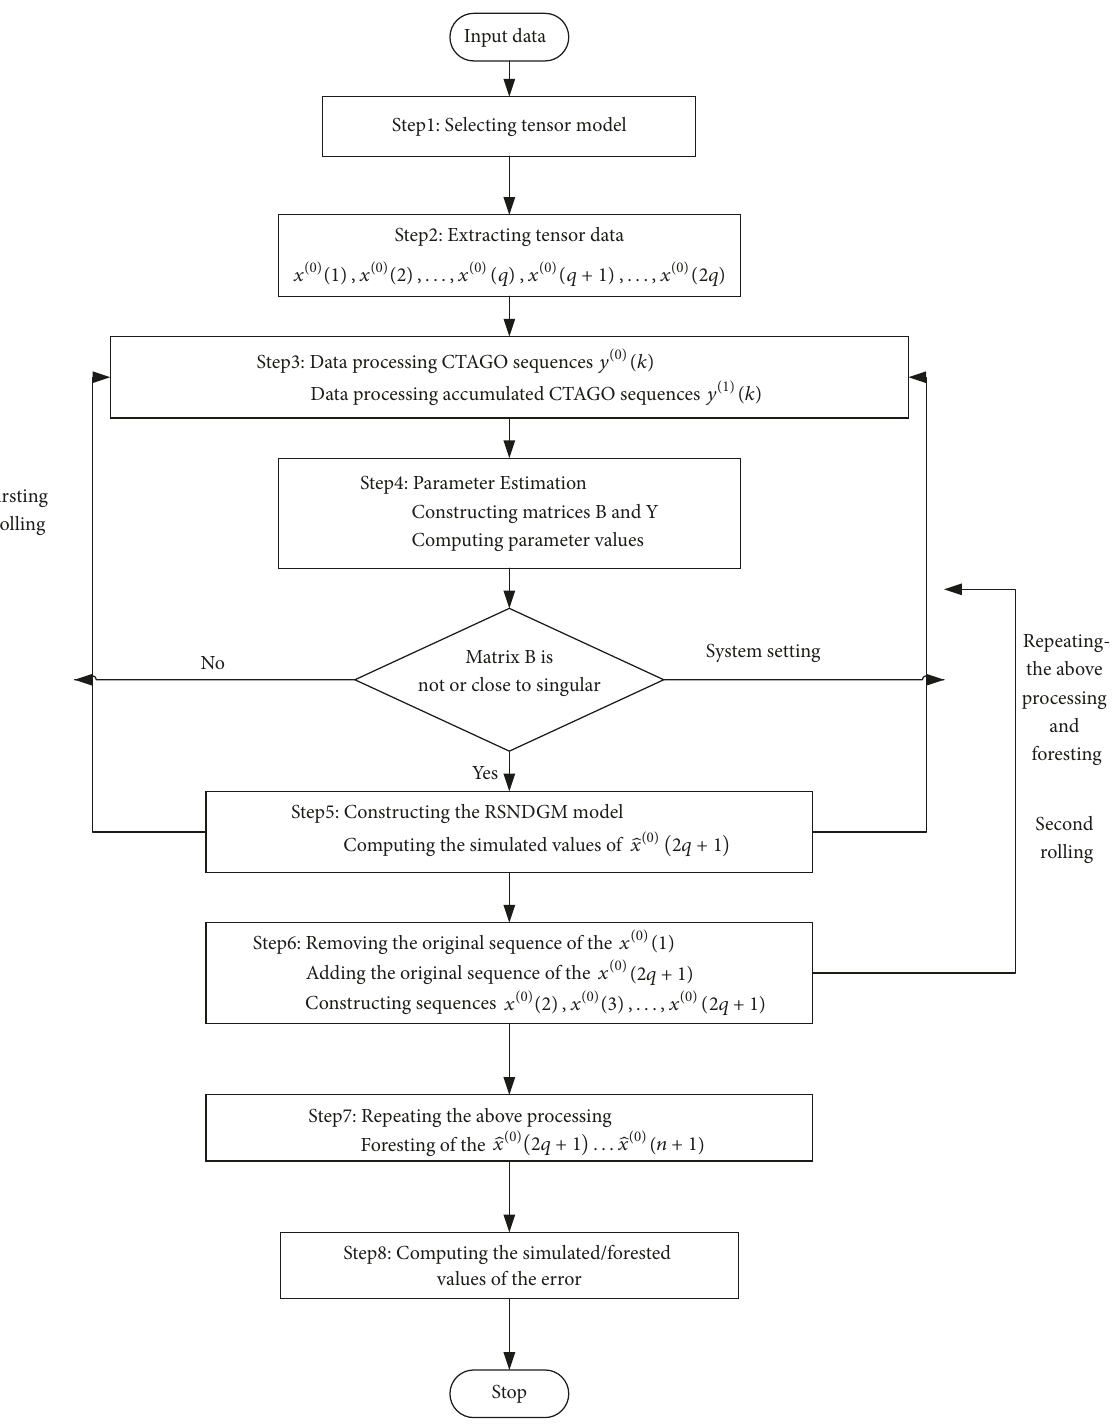
Figure 2: DTRNDGM prediction flow